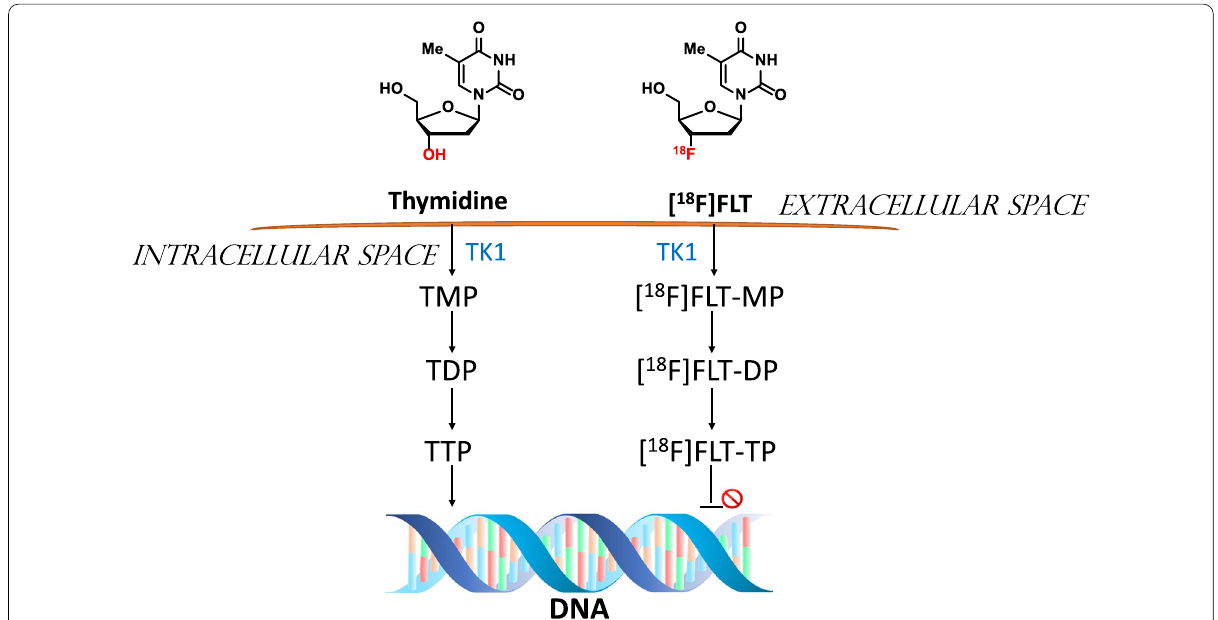
Fig. 1 Summary of [ 18 F]FLT uptake mechanism into cells. [ 18 F]FLT sequestration in the cell after its phosphorylation by thymidine kinase 1 (TK1) into [ 18 F]FLT monophosphate ([ 18 F]FLT-MP), [ 18 F]FLT diphosphate ([ 18 F]FLT-DP) and [ 18 F]FLT triphosphate ([ 18